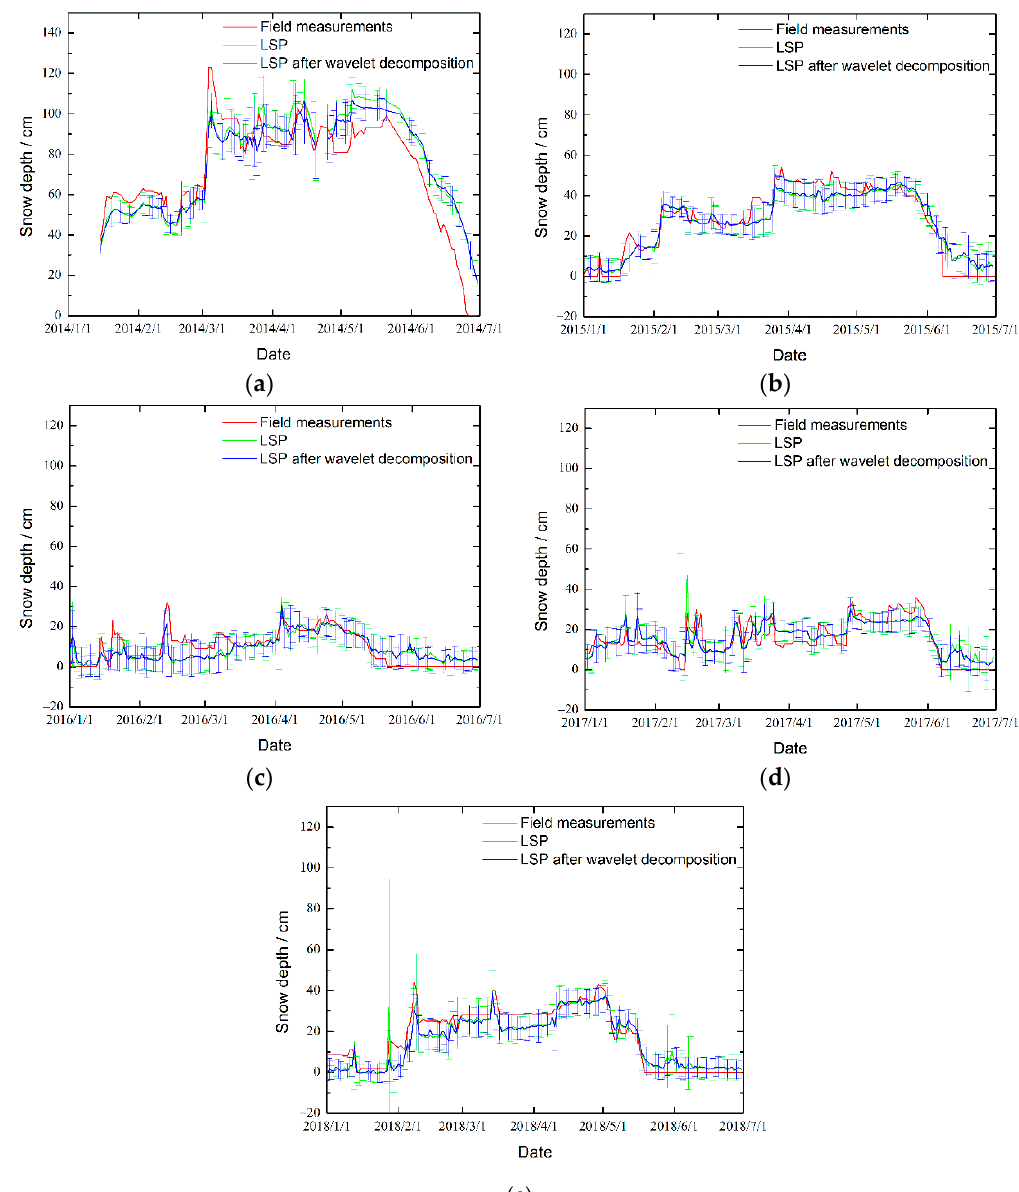
Figure 8. Daily averaged snow depths based on the two methods in 2014 ( a ), 2015 ( b ), 2016 ( c ), 2017 ( d ) and 2018 ( e ). Red line represents the measured snow depth from field work. Green and blue lines denote the snow depths estimated with LSP and LSP after wavelet decomposition, respectively. The error bars show the daily standard deviations of the GNSS-based estimations, and the average standard deviations were ∼ 7.13 and 6.80 cm for LSP and LSP after wavelet decomposition, respectively, as also shown in Table 1.